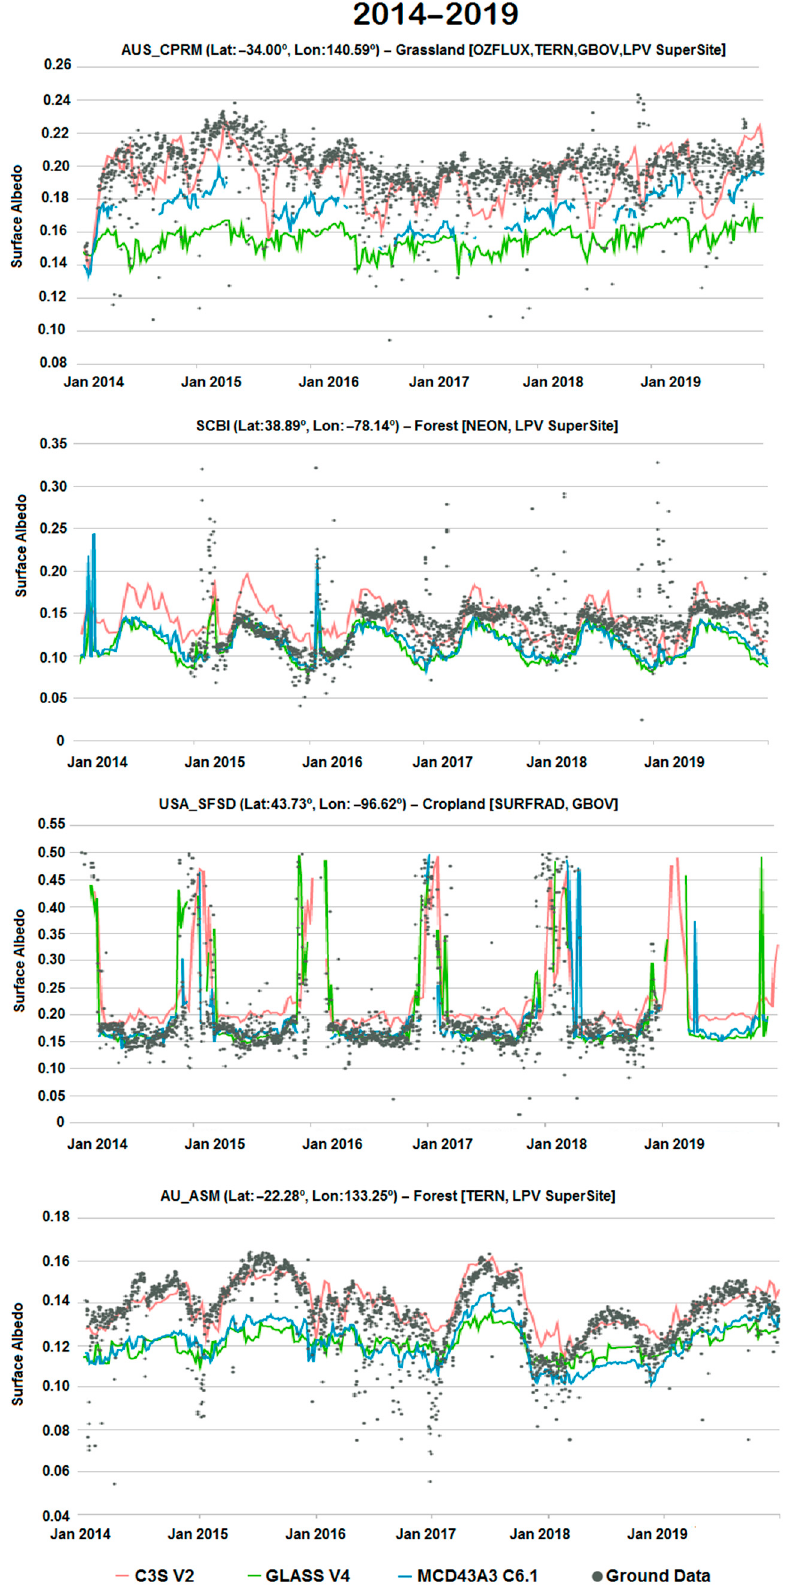
Figure 9. Examples of albedo temporal variations in C3S V2 (red), GLASS V4 (green), and MCD43A3 C6.1 (blue) satellite products (all quality pixels not just high quality) and ground data (black dots) from 4 REALS sites during the 2014–2019 period.